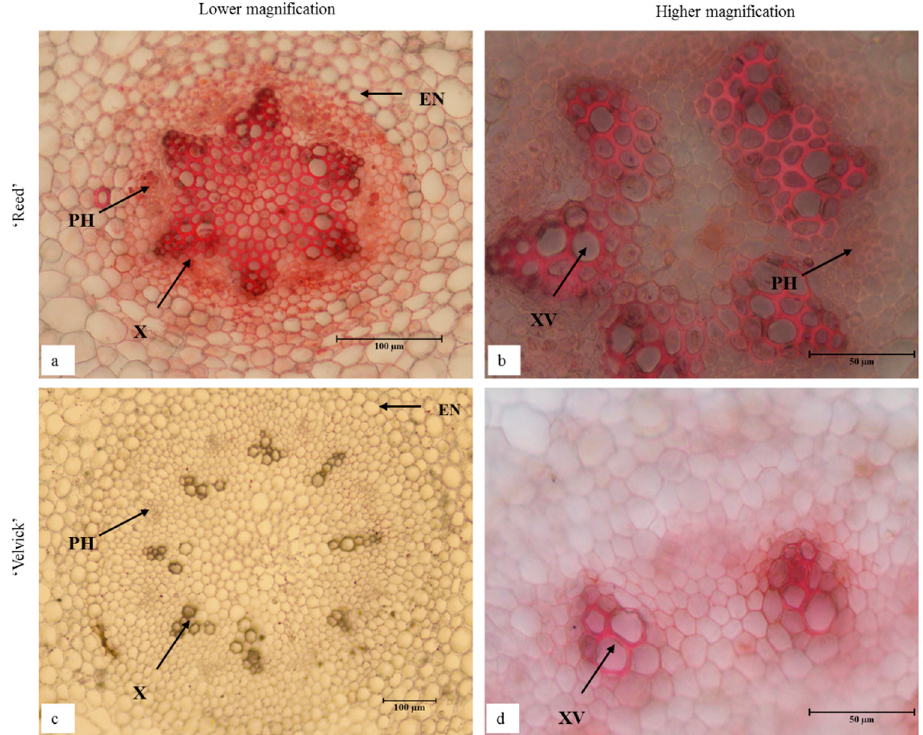
Figure 11. In vitro regenerated roots of ‘Reed’ ( a , b ) and ‘Velvick’ ( c , d ) possessed distinguishable anatomical difference in transverse sections. Fully differentiated large xylem vessels were abundant in the center of ‘Reed’ roots ( a , b ) but ‘Velvick’ had very few large xylem vessels ( c , d ). Secondary cell wall thickening was observed in the endodermis of ‘Reed’ ( a ), but not within the endodermis of ‘Velvick’ ( c ). Sections were cleared with chloral hydrate and stained with Safranin O ( n = 3), X = xylem, XV = xylem vessels, PH = phloem and EN =